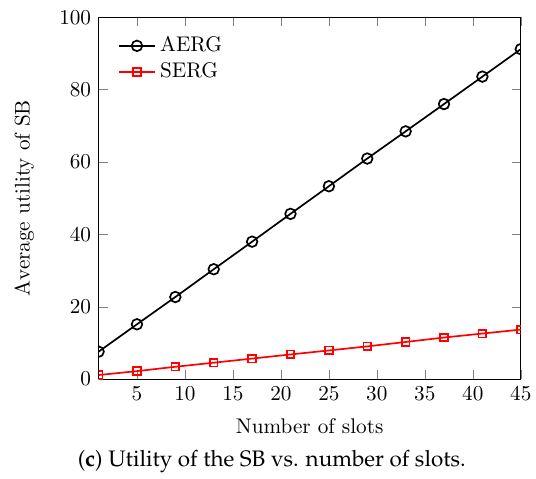
( c ) Utility of the SB vs. number of slots. Figure 9. Average utilities of the agents vs. number of the slots.